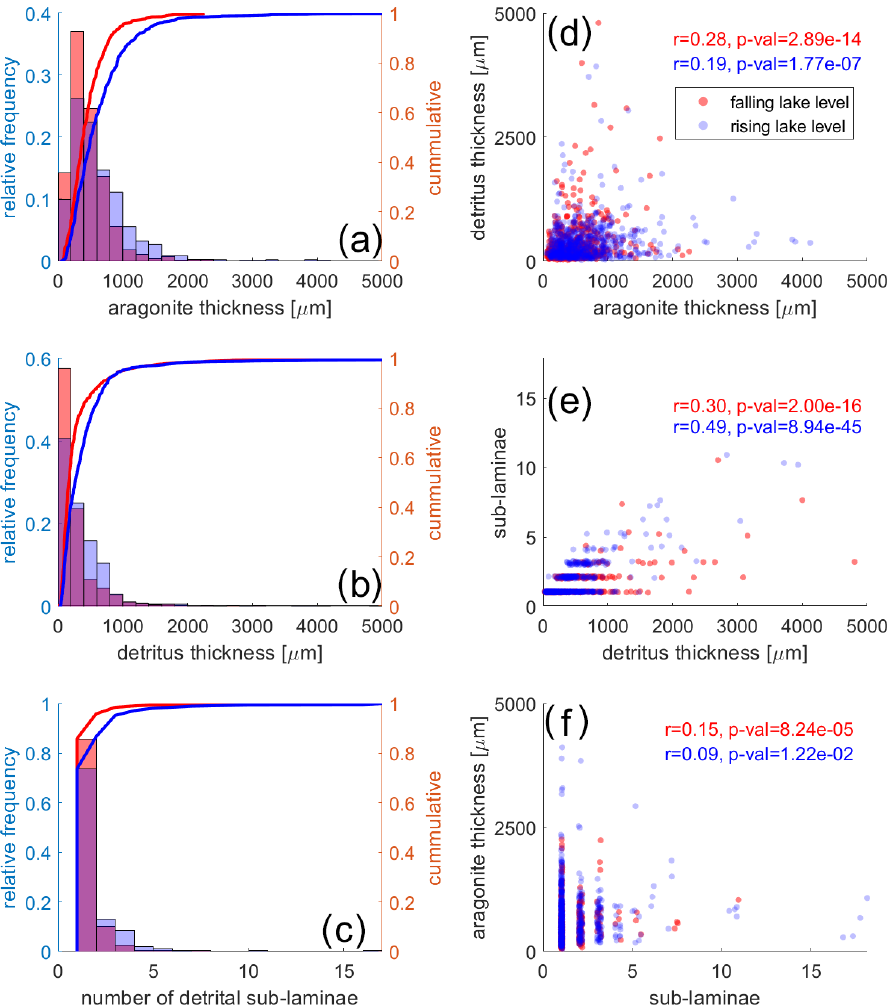
Figure 5. Distributions and scatterplots of the trivariate geological time series showing the distributions of (a) aragonite lamina thickness, (b) detritus lamina thickness, and (c) number of sub-laminae counted in each detrital lamina. Plots (d) – (f) show the correlations between aragonite and detritus thickness ( d , r 2 = 0.08, 0.04), number of floods and detritus thickness ( e , r 2 = 0.09, 0.24), and number of floods and aragonite lamina thickness ( f , r 2 = 0.02, 0.01).